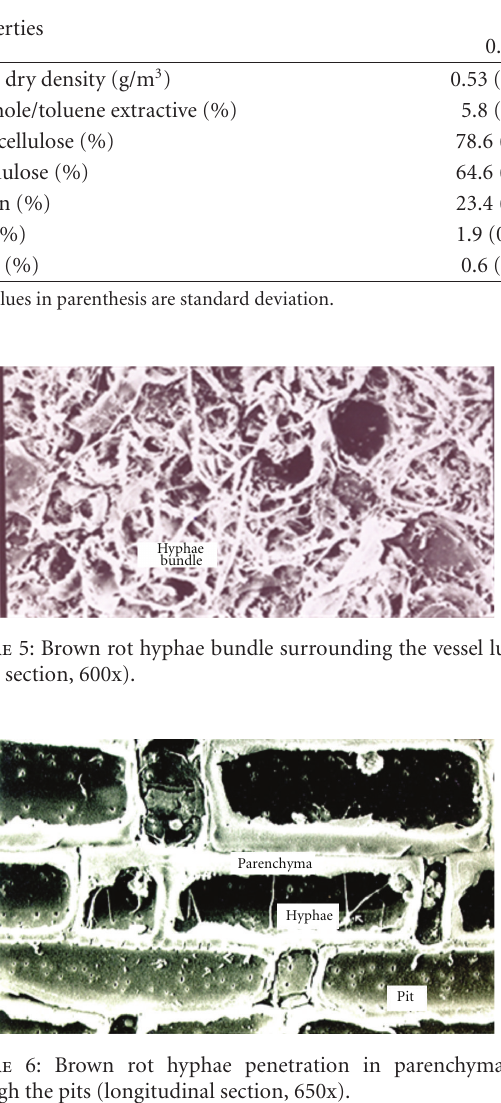
Table 6: Mean chemical contents of G. Scortechinii .